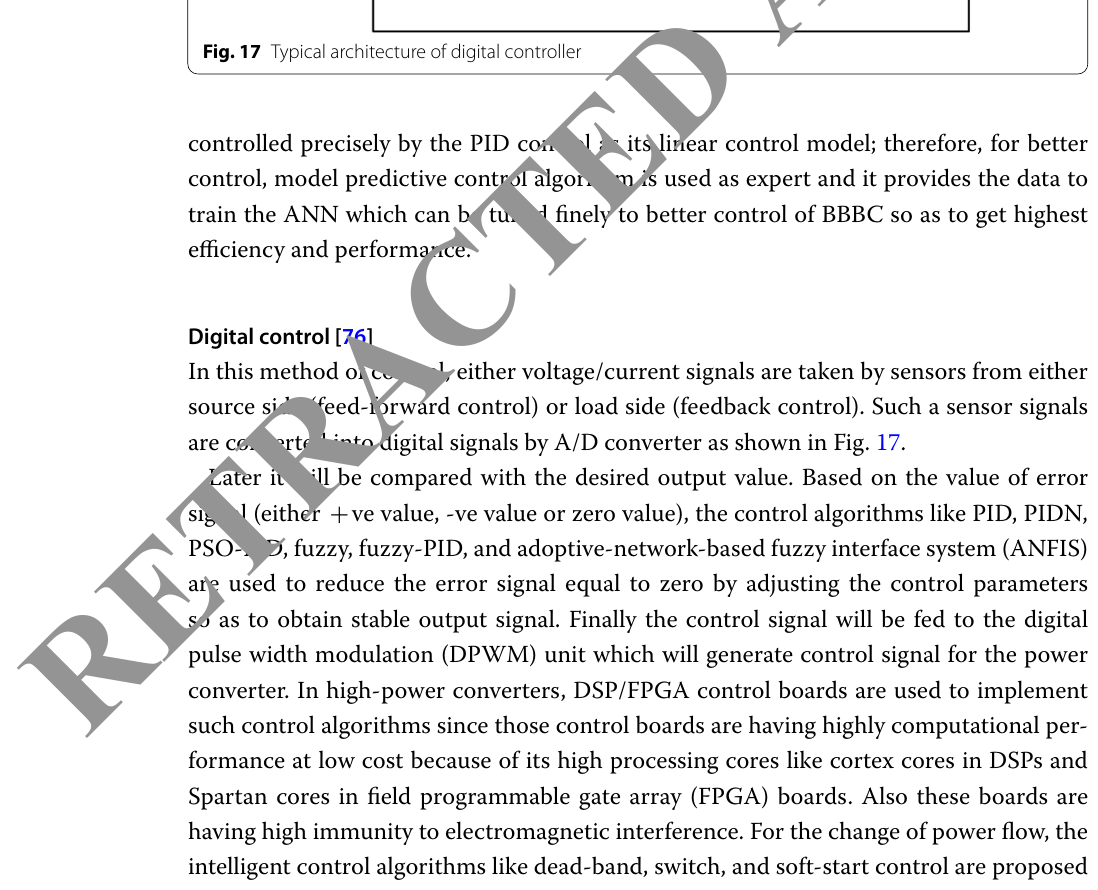
Fig. 17 Typical architecture of digital